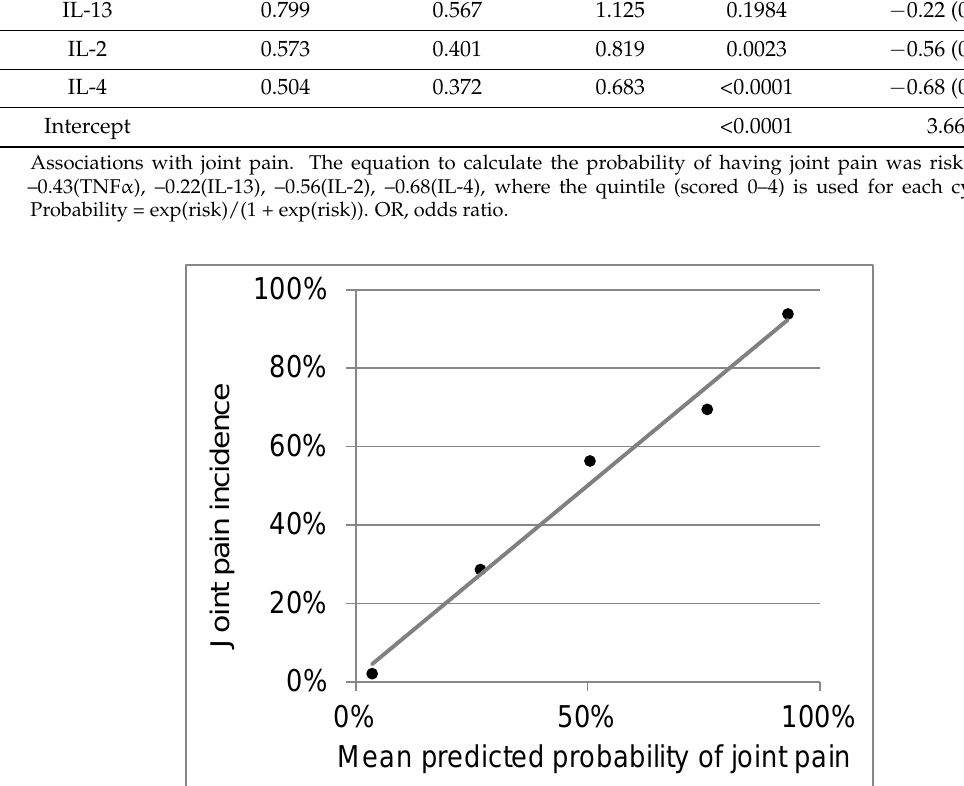
Figure 2. Calibration of the logistic regression model’s risk scores versus incidence of joint pain. There is very strong correspondence between the predicted probability and the observed incidence of joint pain across risk quintiles.